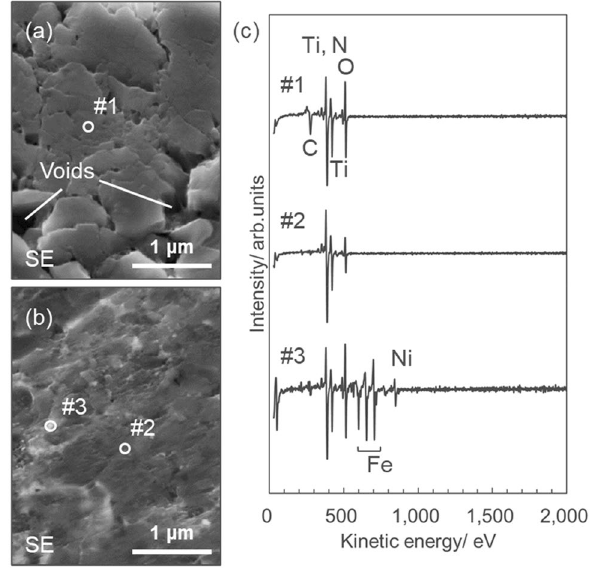
Fig. 2 Surface SE images of a the TiN solid-phase sintered ceramic and b the TiN liquid-phase sintered ceramic. c AES spectrum obtained from areas marked by white open circles in ( a ) and ( b